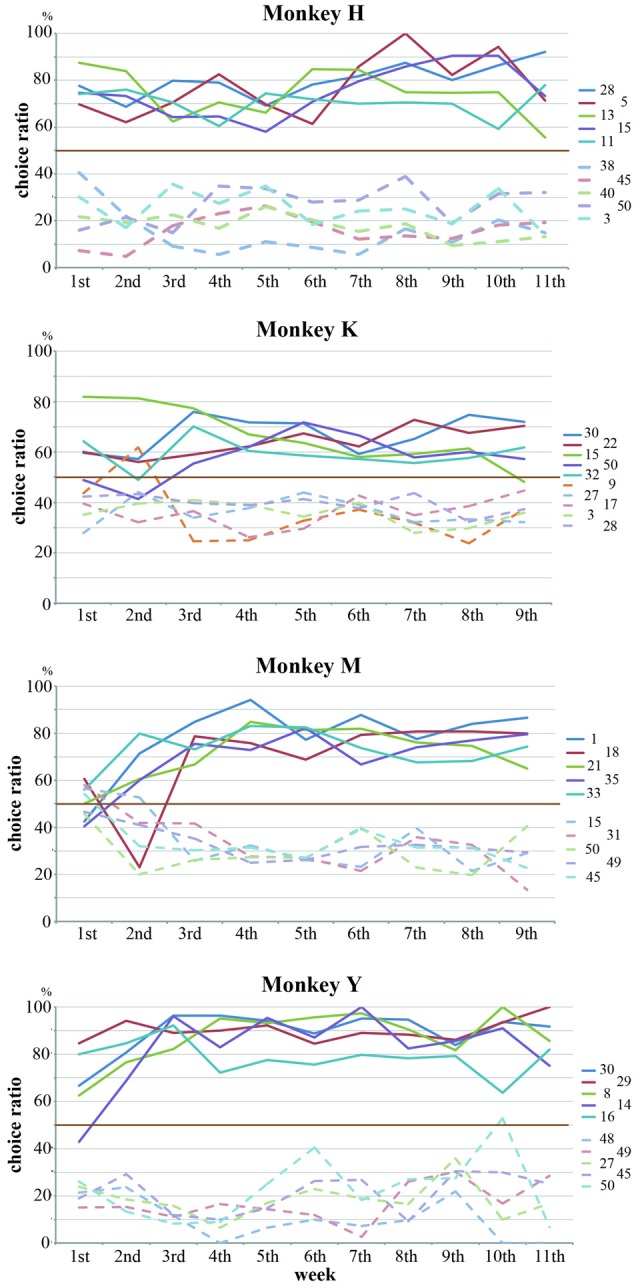
Five stimuli with the highest choice ratios and five stimuli with the lowest choice ratios were selected for each monkey, and the temporal changes in the choice ratios for these stimuli were examined for 9 or 11 consecutive weeks. Although the choice ratios for these stimuli fluctuated during the first or second week, each monkey tended to select some particular stimuli at higher choice ratios and other stimuli at lower choice ratios. Straight lines and dotted lines indicate the temporal changes for the stimuli with higher choice ratios and the stimuli with lower choice ratio, respectively. Different colors indicate the data of different stimuli.